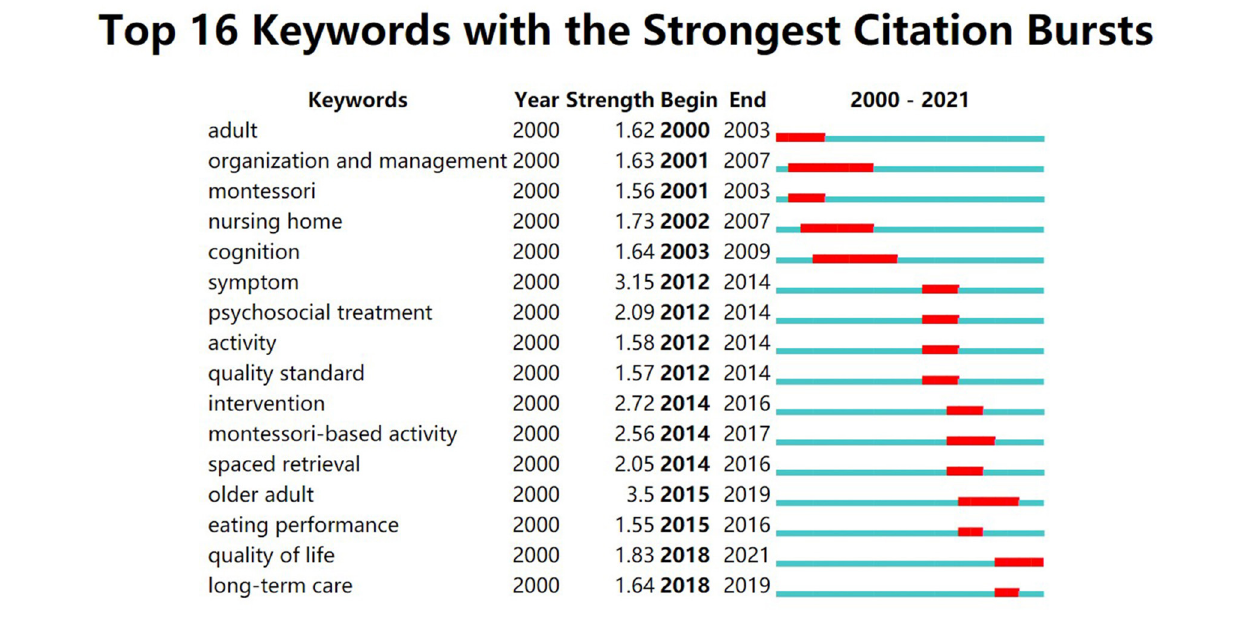
FIGURE 8 | Keyword burst graph of articles published in English on Montessori approach to interventions for patients with dementia from 2000 to